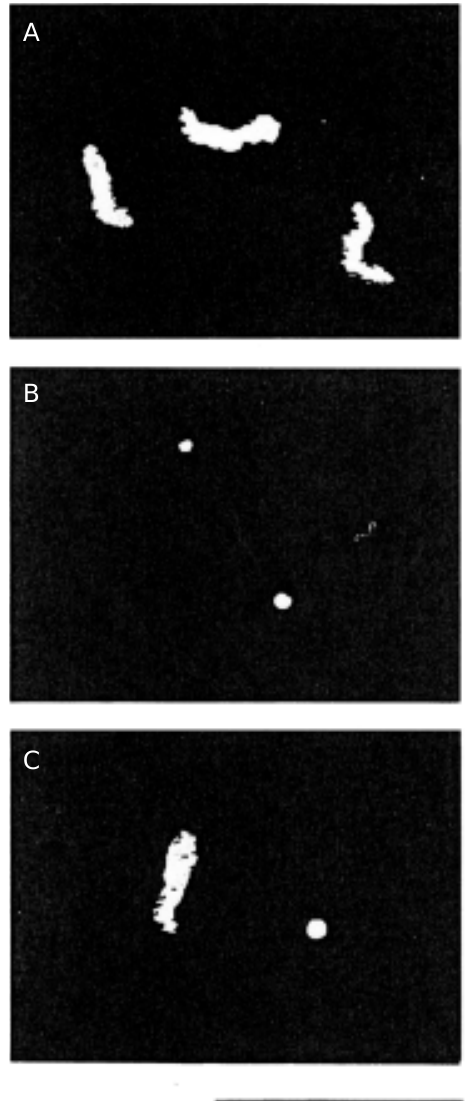
Figure 6. Fluorescence images of T4 DNA molecules moving freely in the buffer solution with the stepwise addition of cetyltri- methylammonium bromide (CTAB). Existence of coil confor- mation of T4 DNA molecules (A), globule conformation (B), and coexistence of coil state and globule state (C). Reprinted from Ref. 30, with